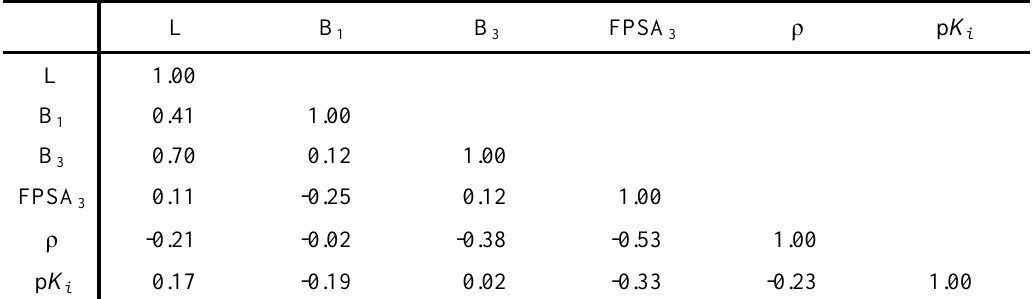
Table 4. Inter-correlation of binding affinity and descriptors from QSAR equation